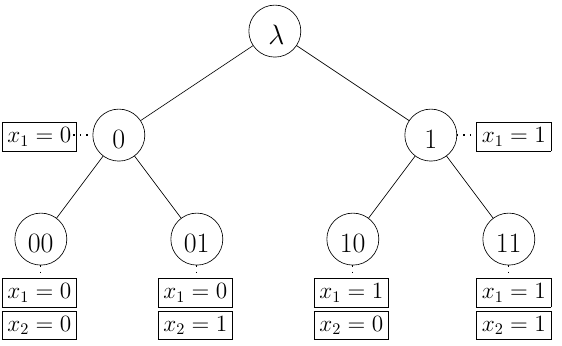
Figure 1. Complete binary tree of height 2. Nodes hold branch labels, and are decorated with attributes that are explicit corresponding variable allocations. Branches 01 and 10 correspond to solutions for the formula of Example 1, ( x 1 ∨ x 2 ) ∧ ( x 1 ∨ x 2 )